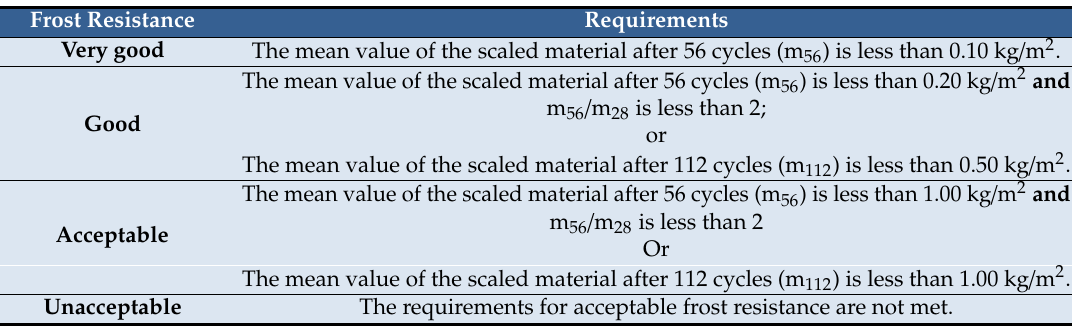
Table 2. Acceptance criteria for the frost scaling resistance of concrete according to SS 13 72 44 (2005). Frost Resistance Requirements